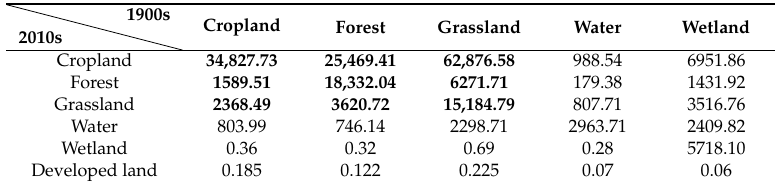
Table 1. Total area of conversion from the 1900s to 2010s (unit of 10 4 km 2 ). Note there are no developed lands in the 1910s. The three primary classes are highlighted in bold.